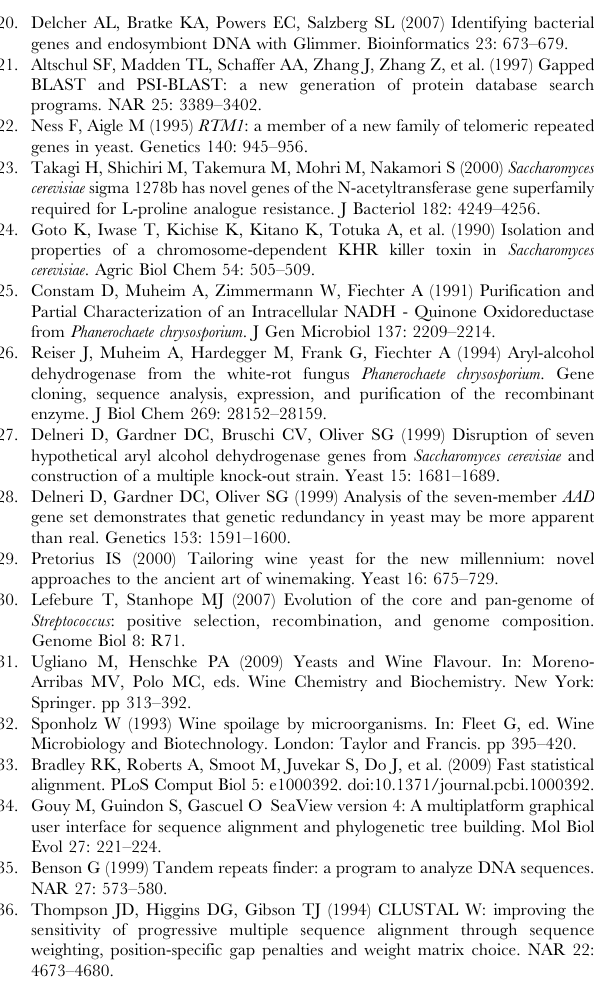
Table S3 Instances of the five-gene